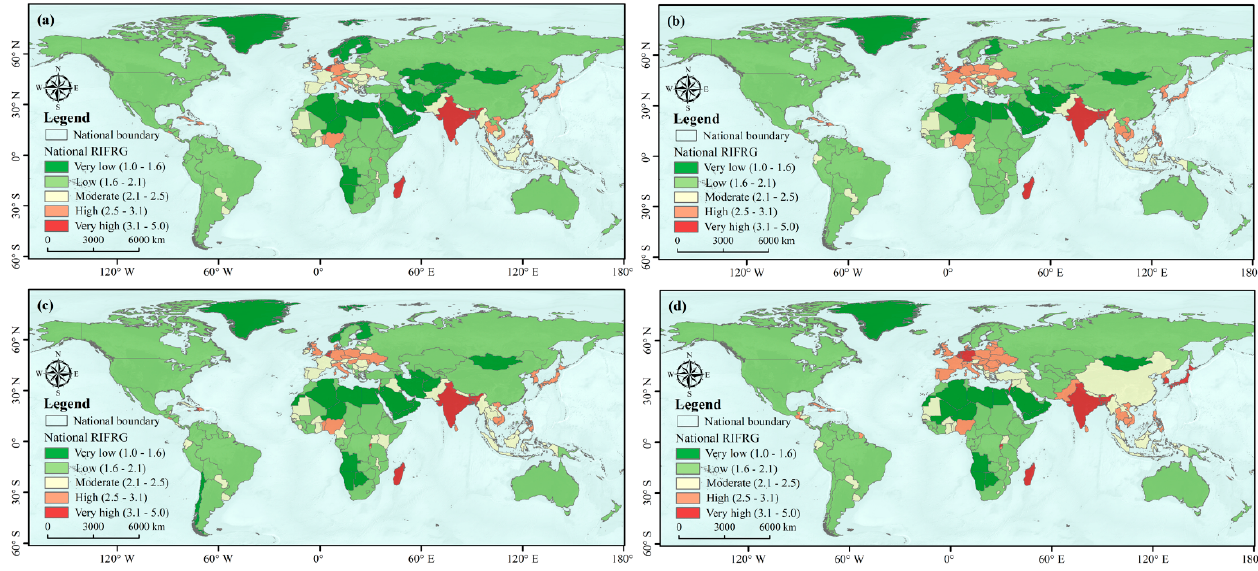
Figure 7. Spatial distributions of the national RIFRGs in ( a ) 2005, ( b ) 2010, ( c ) 2015, and ( d ) 2020. To explore more deeply the changes in the risk values over the time series for individual countries, the RIFRG values on the national scale were reclassified into five categories, with changes greater than or equal to one level being considered significant. Figure 8 indicates that flood risk showed the following trend: significantly increasing, leveling off, and then significantly increasing again. From 2005 to 2010 (Figure 8a), more than 10 countries were at significantly increased risk (Kazakhstan, Tajikistan, Ukraine, Sweden, Norway, Angola, South Africa, Ecuador, etc.), while a few countries were at significantly decreased risk, namely, Ireland, Denmark, and Turkmenistan. Subsequently, in 2010–2015, the number of countries at a significantly increased risk was about the same as the number of countries at a decreased risk (Figure 8b). However, the trend in risk change for the period of 2015–2020 returned to an increasing trend (Figure 8c), and the increasing trend was even greater than that for the period of 2005–2010 (Figure 8a). Specifically, these countries at significantly increased risk were mainly located in Asia and Europe, while countries at significantly decreased risk were mainly located in Africa (Figure